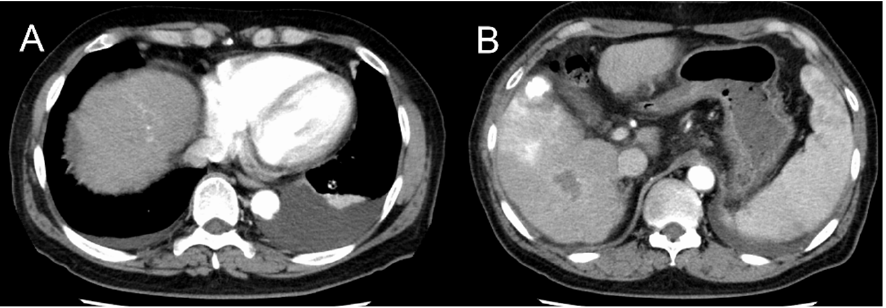
Figure 2. Imaging after two months of treatment for hepatocellular carcinoma. ( A ) Left pleural effusion and ascites have decreased compared to pretreatment. ( B ) There is lipiodol deposition coincident with the mass and no recurrence of hepatocellular carcinoma.